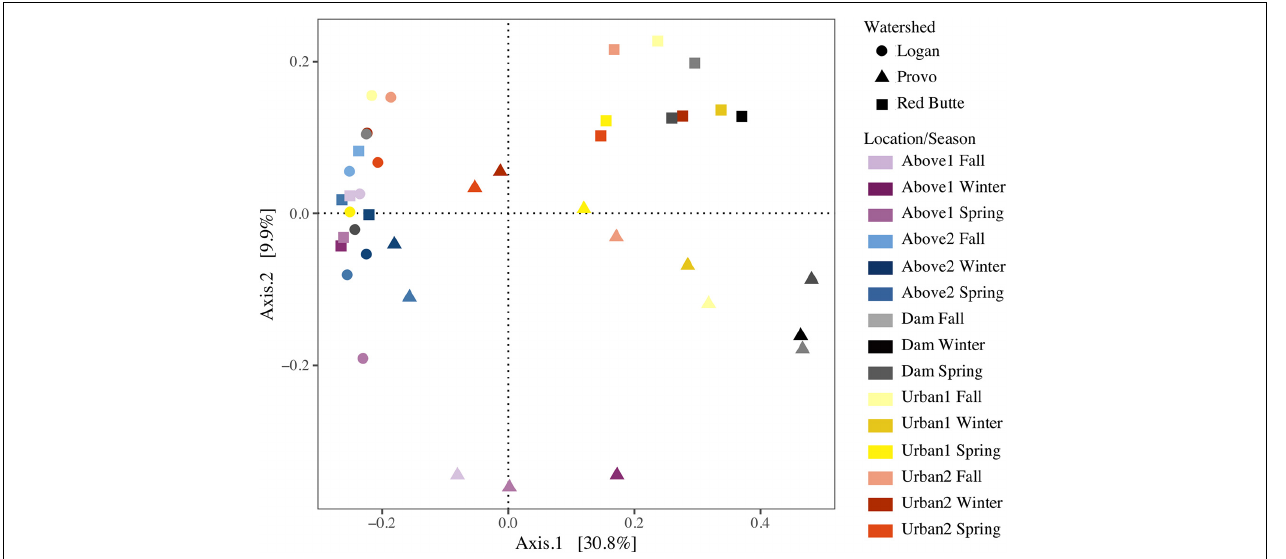
FIGURE 5 | Reservoirs alter stream bacterial community composition from three watersheds in Utah’s Wasatch Range Metropolitan Area (Red Butte Creek, Provo River, and Logan River) across three seasons (Fall, Winter, and Spring). Graph represents a Principal Coordinate Analysis (PCOA) ordination, with each point representing a community of bacterioplankton classified at the 97% similarity from 16s rRNA gene amplicon sequencing of OTUs. Location indicates position relative to man-made reservoirs and urban centers. Points closer together are more similar (based on Bray-Curtis dissimilarity index), while points farther apart are dissimilar.